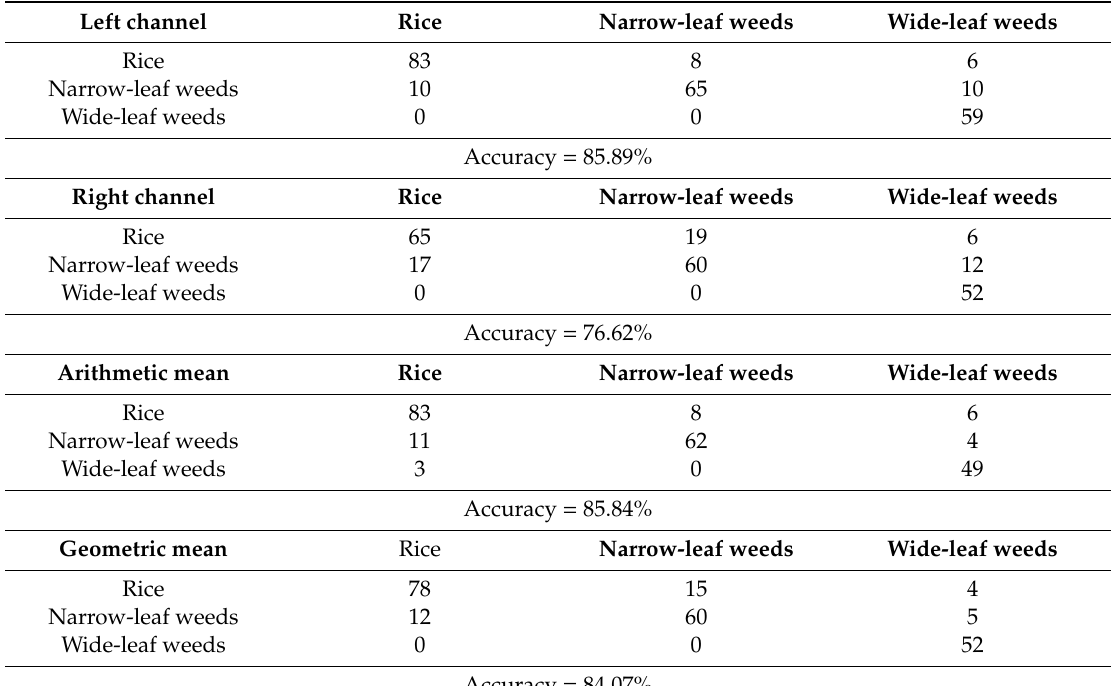
Table 6. Confusion matrices and accuracy of the K-nearest neighbors (KNN) classifier for the left channel, right channel, arithmetic mean, and geometric mean (test